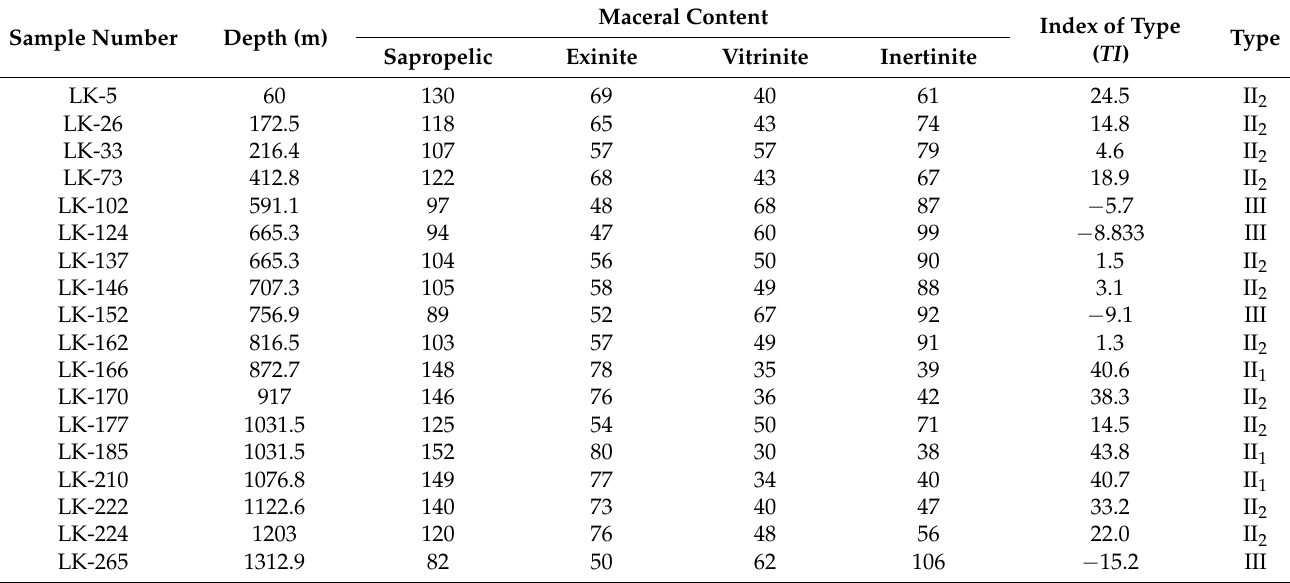
Table 2. Macerals and the kerogen types of overmature source-rock samples from the Laiyang Formation in well